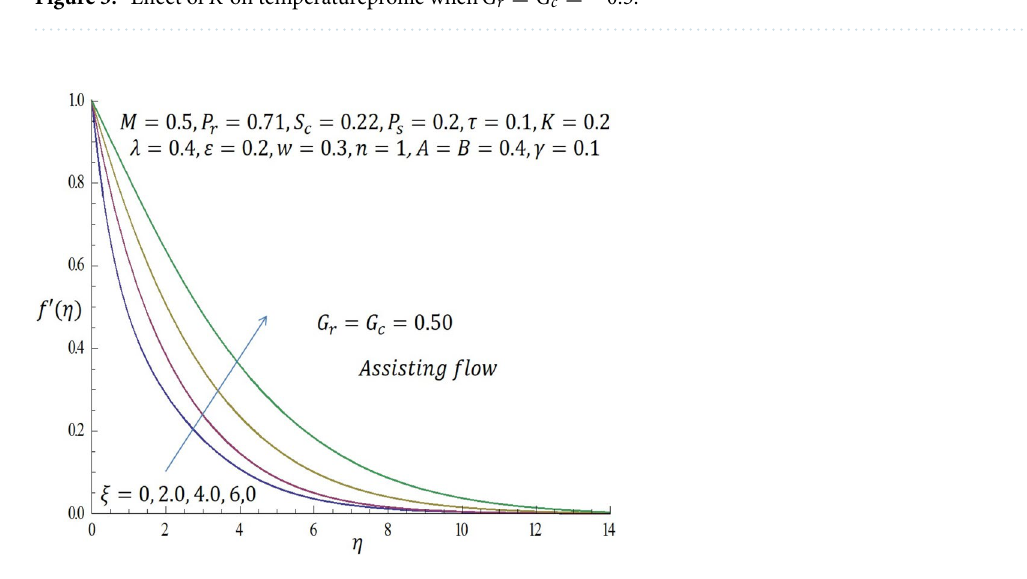
Figure 5. Effect of K on temperatureprofile when G r = G c = − 0.5.